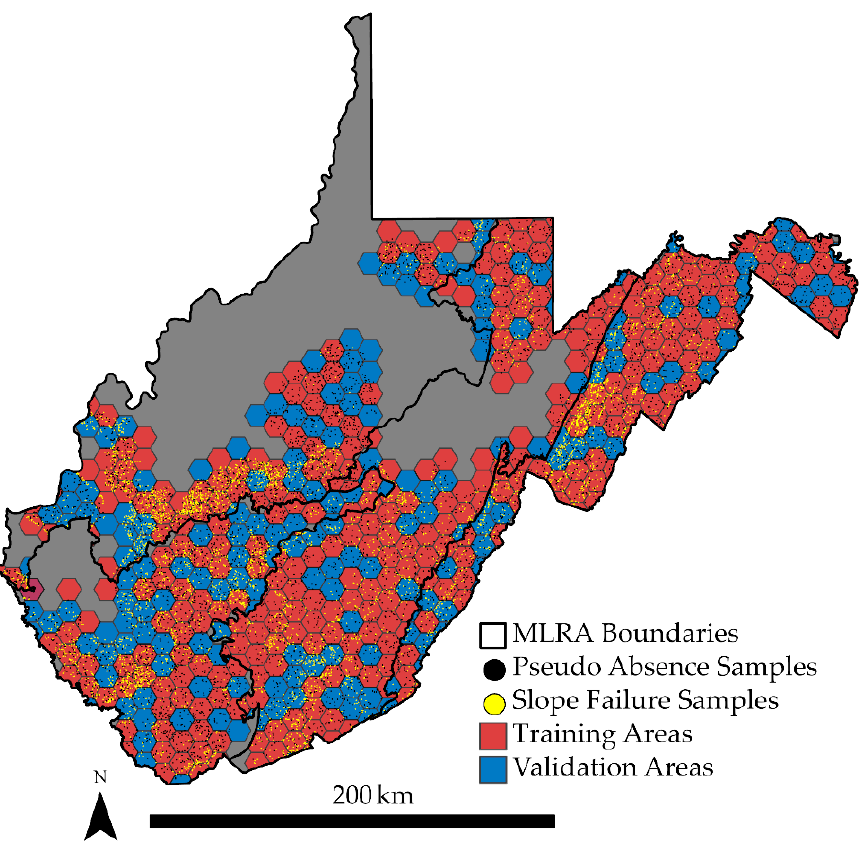
Figure 3. Hexagon tessellation used to define training and validation regions within each MLRA with associated slope failure and pseudo absence samples.